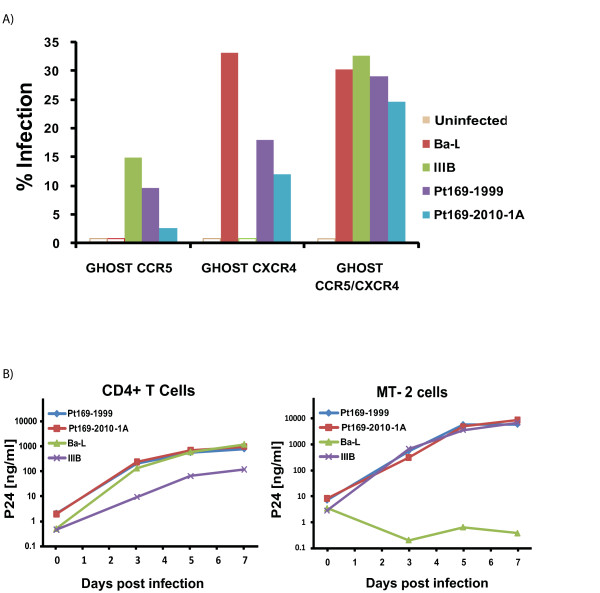
Phenotypic analyses of viral isolates from Patient 169. (A) Viral tropism was determined using GHOST cells expressing CCR5 and/or CXCR4. Open bars were below the limit of the detection (B) Replication kinetics was determined in primary CD4+ T cells (left) and the MT-2 cell line (right).